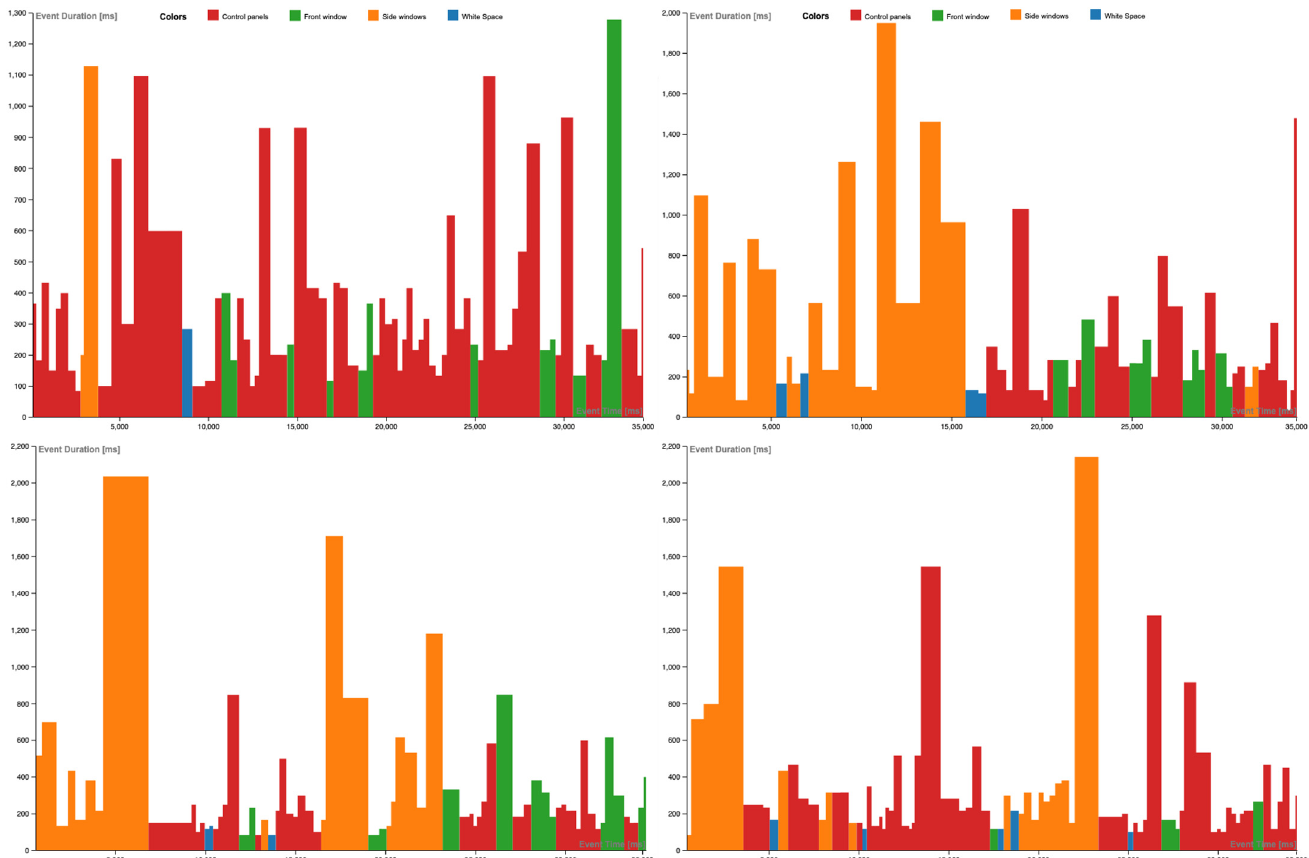
Figure 11. Analysis of fixations during train departure from the station or a railway stop.